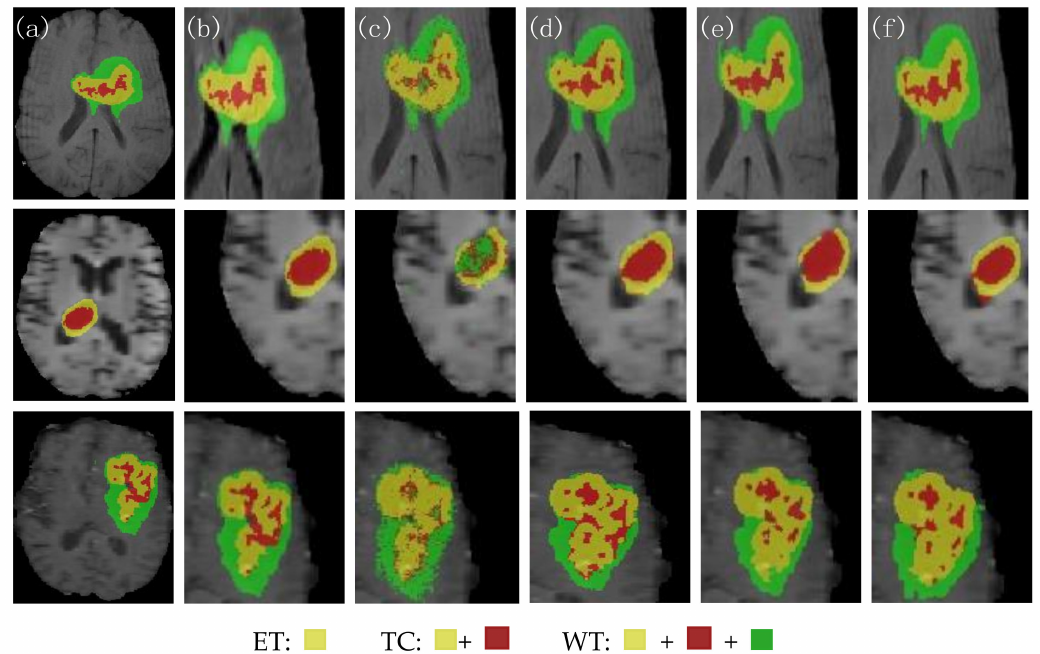
Figure 9. Comparison of the segmentation effects of the different network models. ( a ) GT; ( b ) local expansion; ( c ) 3D Unet; ( d ) CBAM Unet; ( e ) TransBTS; ( f ) 3D BCS_T; From the perspective of